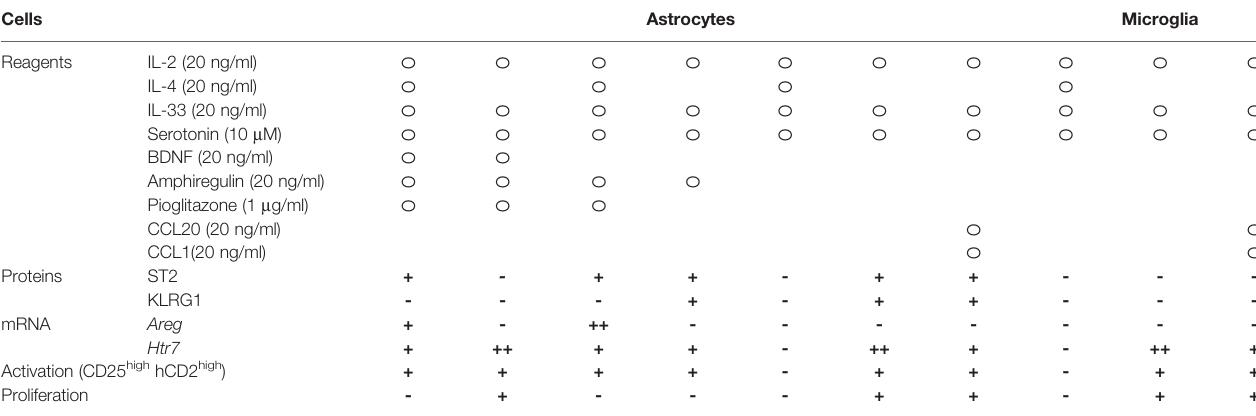
SplenicTregswereco-culturedwithastrocytesormicrogliafor6daysinthepresenceoffactorcombinations(o).BrainTregmarkersST2andKLRG1wereanalyzedusingFACS,andAreg and Htr7 were analyzed using qPCR. Treg activation (Foxp3 high and CD25 high expression) and proliferation were also analyzed. -, no increase; +, positive; ++, highly positive.